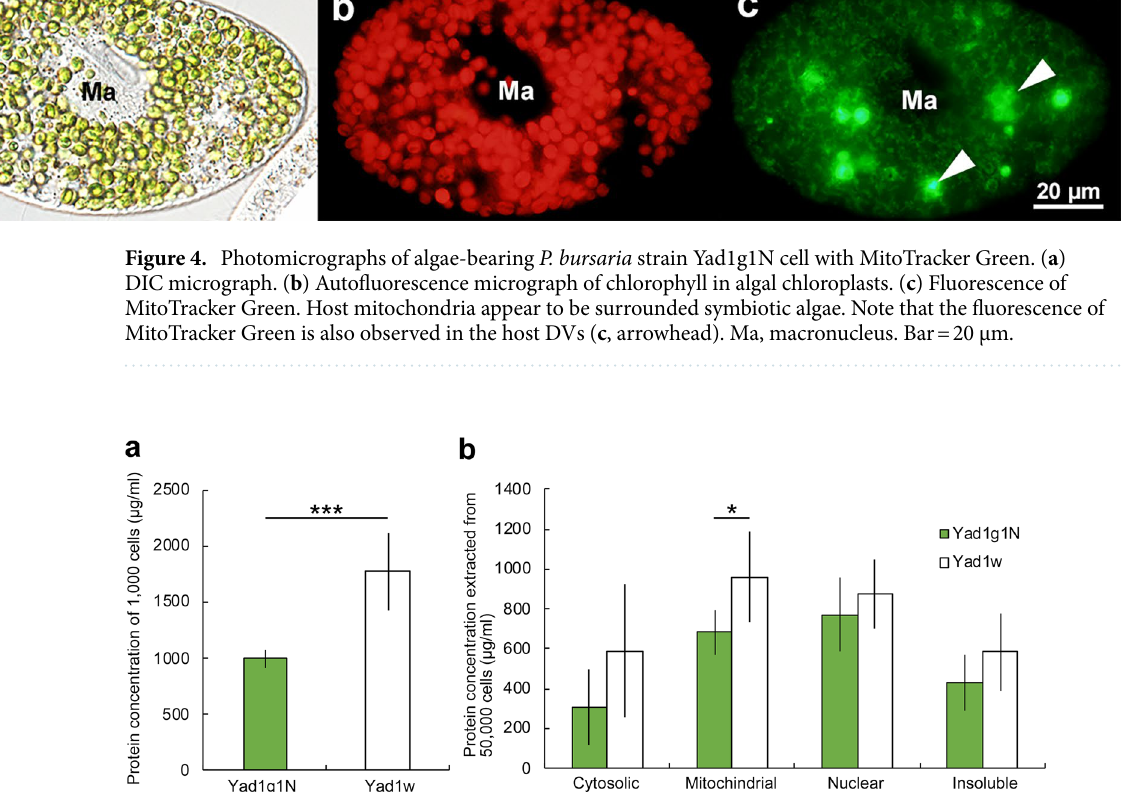
Figure 5. ( a ) Total cell protein concentrations of alga-free (white bar graph) and algae-bearing (green bar graph) P. bursaria cells. The protein concentration of alga-free P. bursaria cells was about 1.8 times higher than that of algae-bearing cells. ( b ) Protein concentration of each cell extract of alga-free (white bar graph) and algae- bearing (green bar graph) P. bursaria cells. The four extracts are cytosolic, including mitochondrial membrane, nuclear, and insoluble. The protein concentration including mitochondrial membrane of alga-free P. bursaria cells was significantly higher than that of algae-bearing cells. Error bars show the standard deviation (SD) obtained from experiments 5 ( a ) and 4–6 ( b ). Asterisks indicate significant differences (two-sided Fisher’s exact test, *** P <0.001, * P < 0.05).